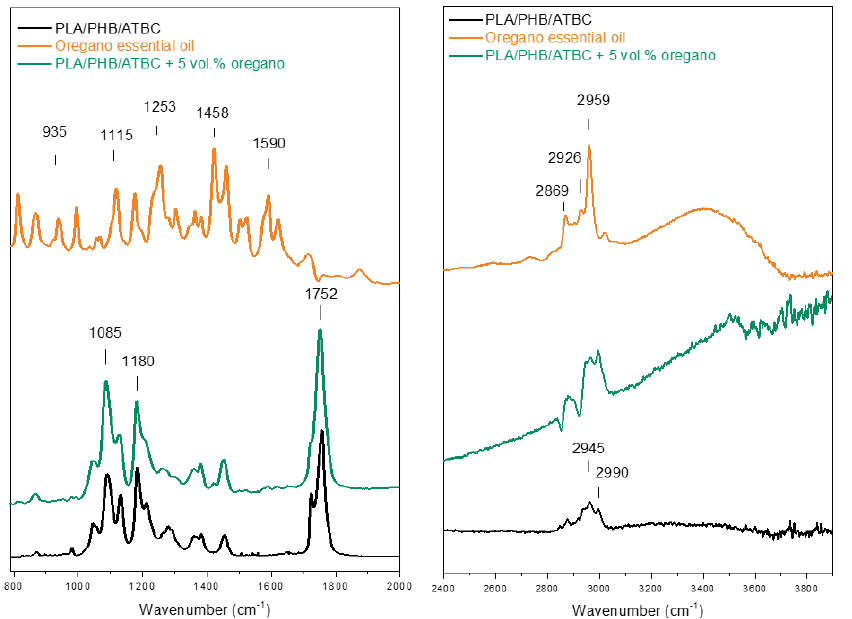
Figure 3. ATR-FTIR spectra of neat PLA/PHB/ATBC, oregano EO, and PLA/PHB/ATBC + 5% oregano EO nanofibrous composite.